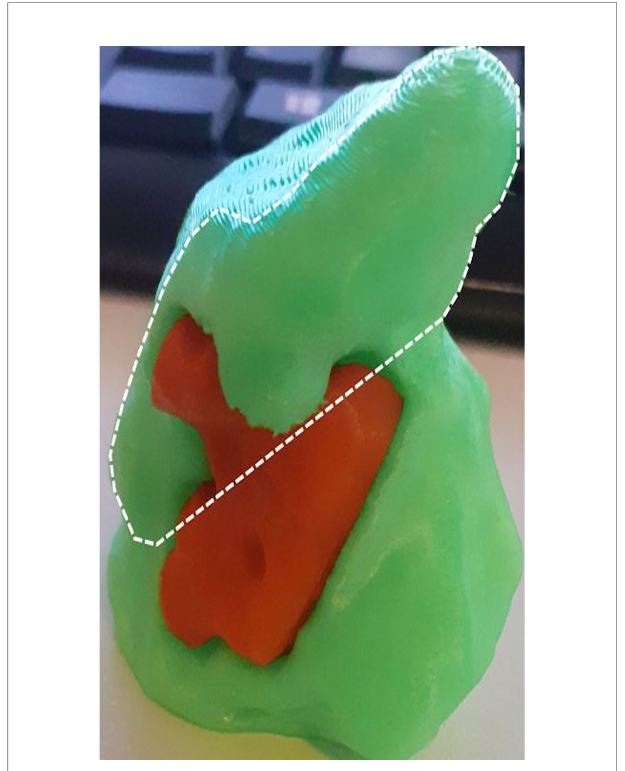
FIGURE 2 | Lateral view of the 3D-printed model shows the protuted tongue (inside the dotted line), the fl oor of the mouth (outside the dotted line), and the tumor in red.